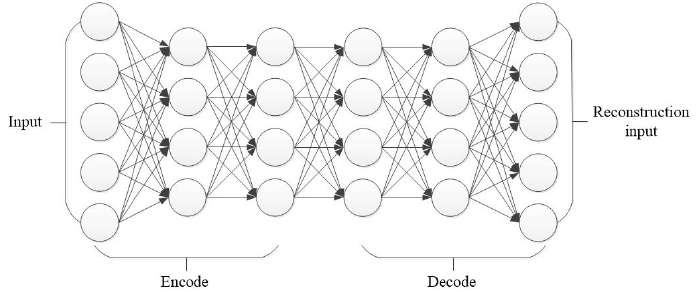
Figure 4. The stacked denoising auto-encoder network is stacked by two encoding layers and two decoding